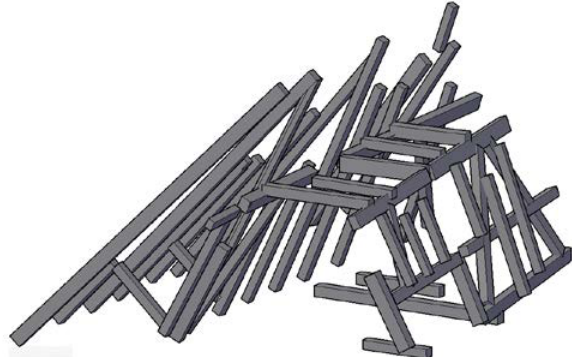
Figure 10: 3-D model containing beams represented by cuboids